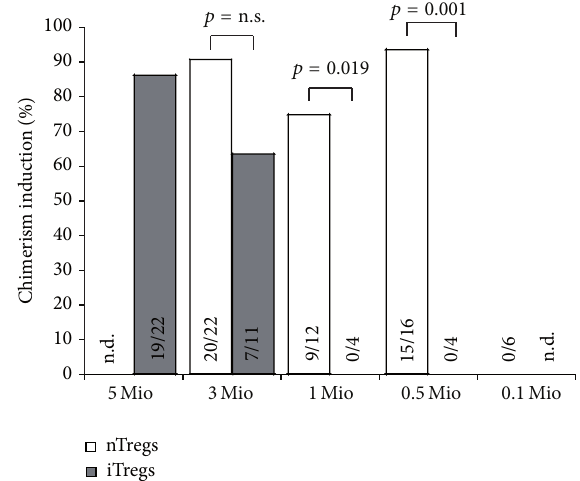
Figure 1: nTregs are superior to iTregs in the induction of mixed